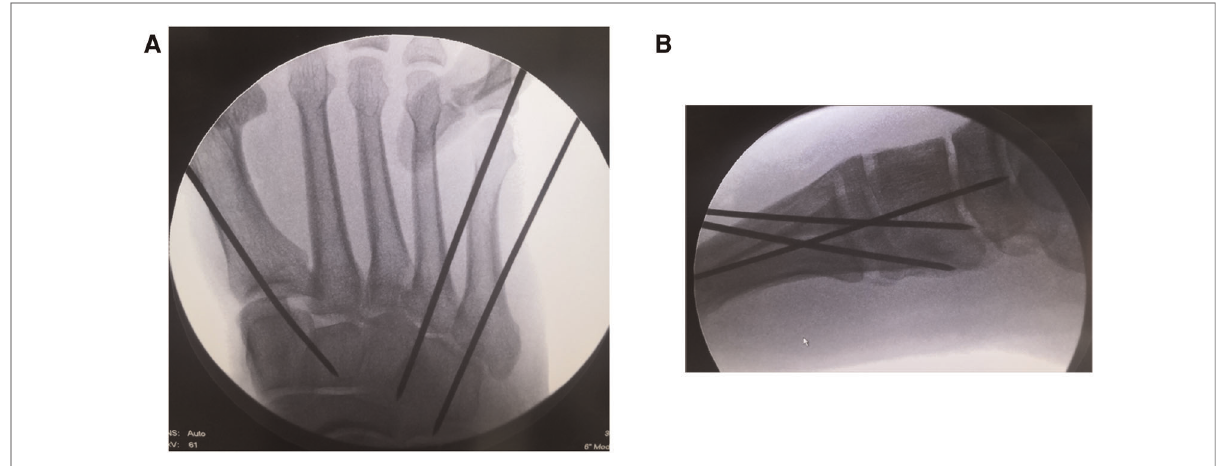
FIGURE 4 Intraoperative fl uoroscopy. Stage II surgery Lisfranc injury with open